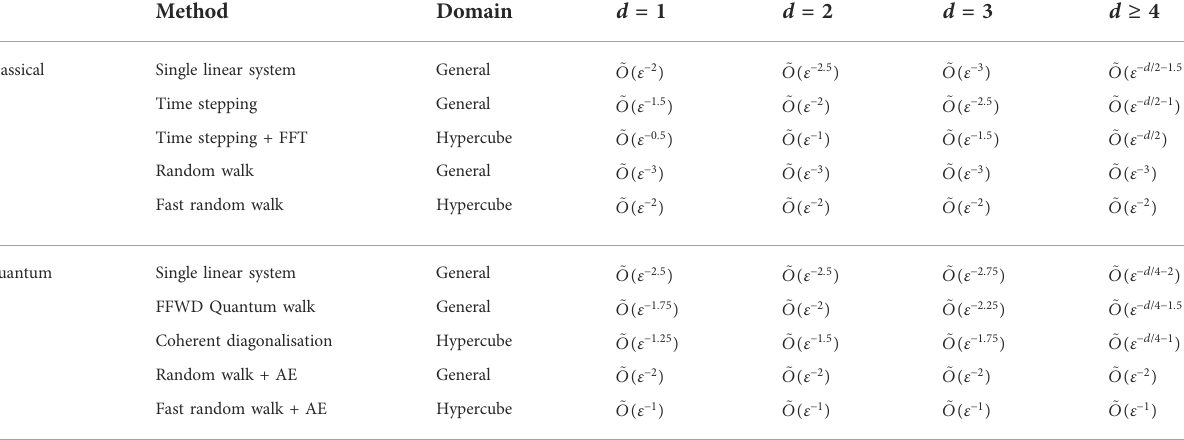
TABLE 2 Runtime comparison of classical and quantum methods for solving the FTCS heat equation (Linden et al., 2020). All runtimes are expressed in terms of terms of spatial dimensions d and error ε on the estimated temperature integral. The ~ O notation hides polylogarithmic factors in the complexity. Adapted from Linden et al.